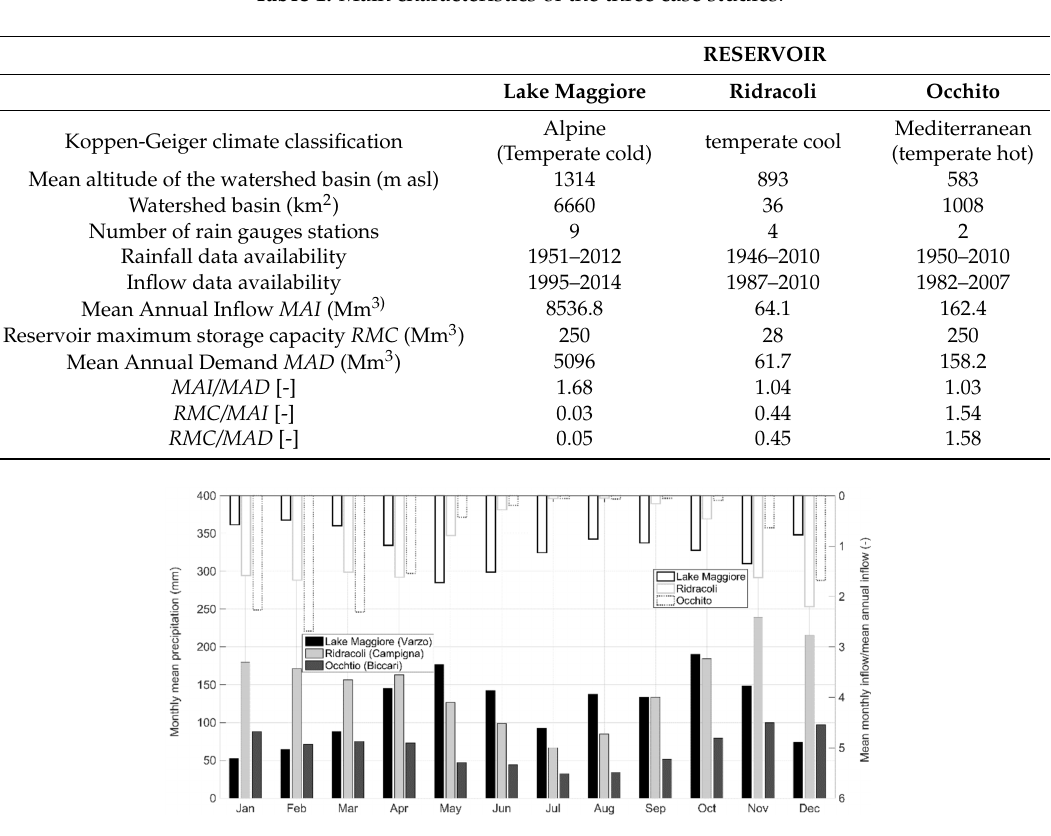
Figure 5. Precipitation (left y -axis) and standardized inflow to the three reservoirs (right y